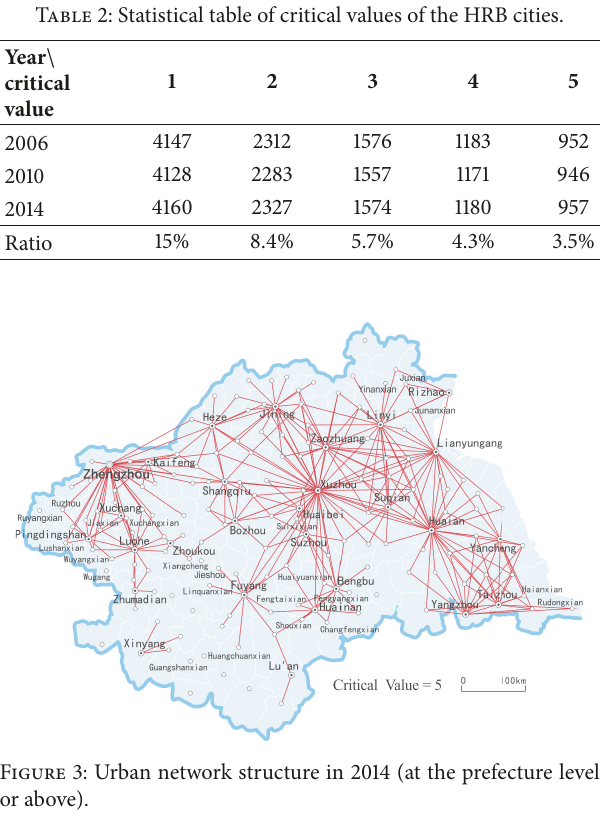
Table 2: Statistical table of critical values of the HRB cities.